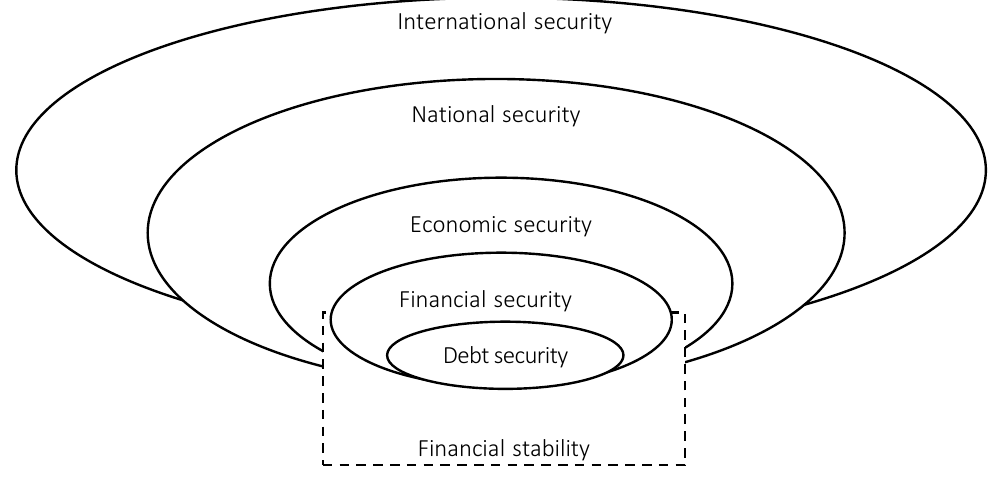
Figure 1. Establishing the government debt security place in the overall